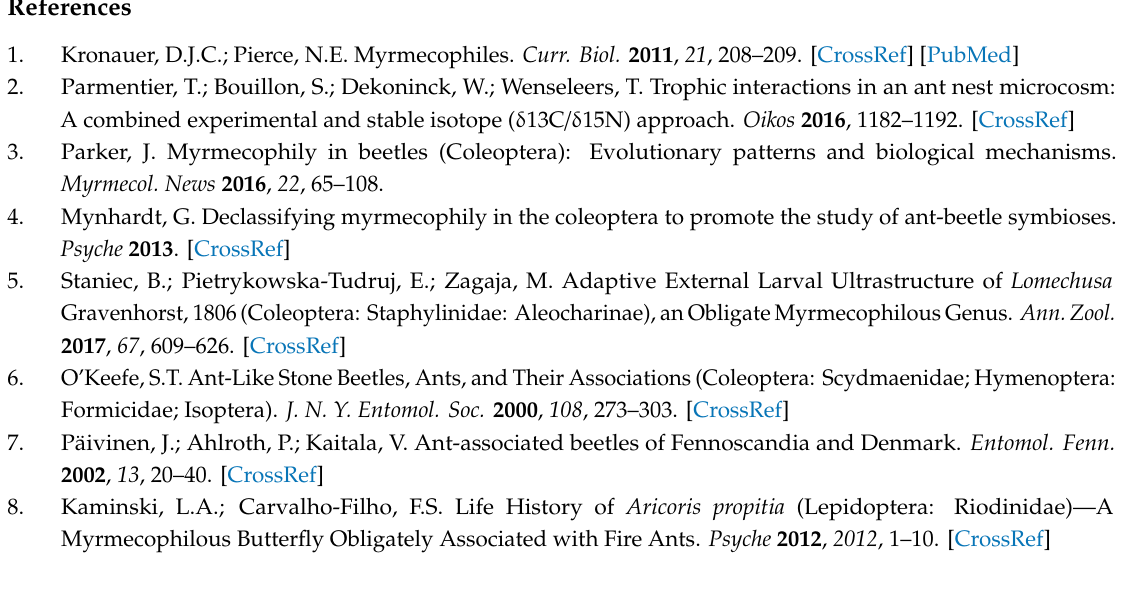
Figure S1: Rarefaction curves with Chao1 diversity indices, indicating insect microbiome sampling depth and saturation, Figure S2: Detailed taxonomic analyses at di ff erent ranks for DNA. Sunburst charts show the relative abundance of microbial 16S rDNA sequences at di ff erent taxonomic levels. The first level represents the kingdom; the second level represents all phyla present in a particular sample; subsequent next levels represent the class, order, family and genus, Figure S3: Relative abundances of bacterial families primarily responsible for observed di ff erences among profiles, Table S1: Sheet 1—Summary of the sequencing data and statistical analysis of bacterial communities associated with F. polyctena and selected myrmecophilous beetles. Sheets 2-6—Detailed taxonomic analyses at di ff erent ranks with the data obtained for the samples tested. The table shows the relative abundance of microbial 16S rDNA sequences at di ff erent taxonomic